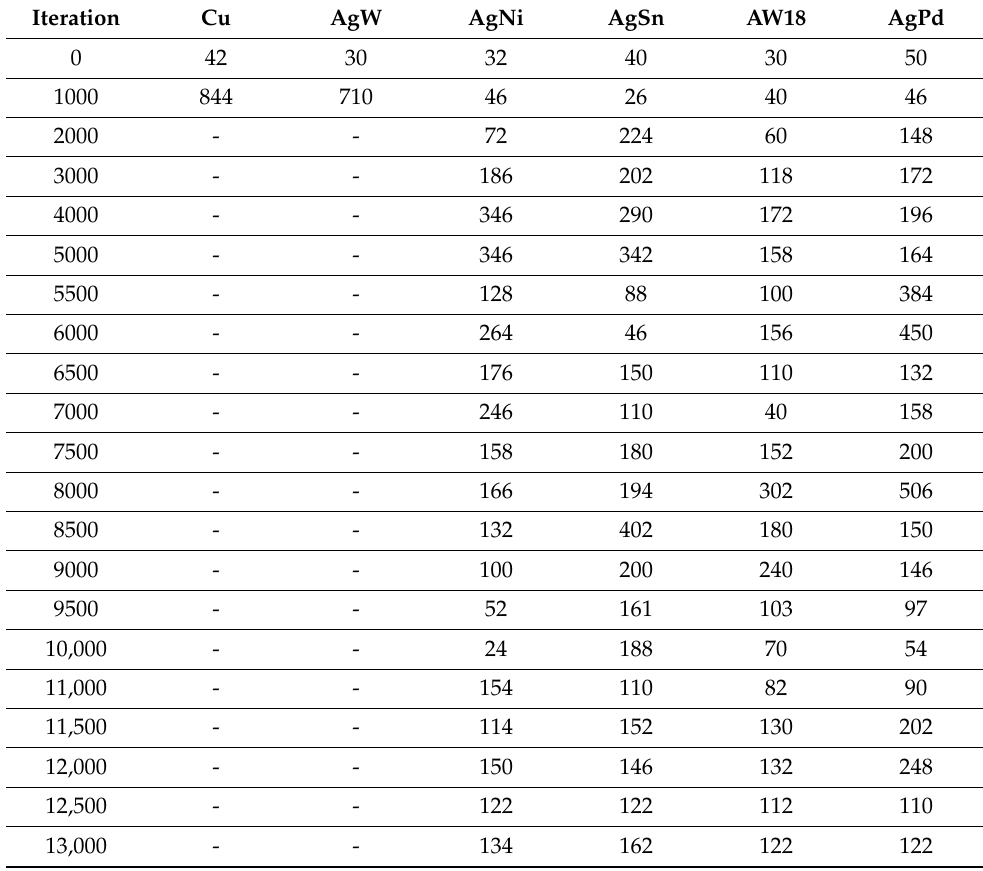
Table 4. Voltage drop between switch contacts under 400 V/10 A load